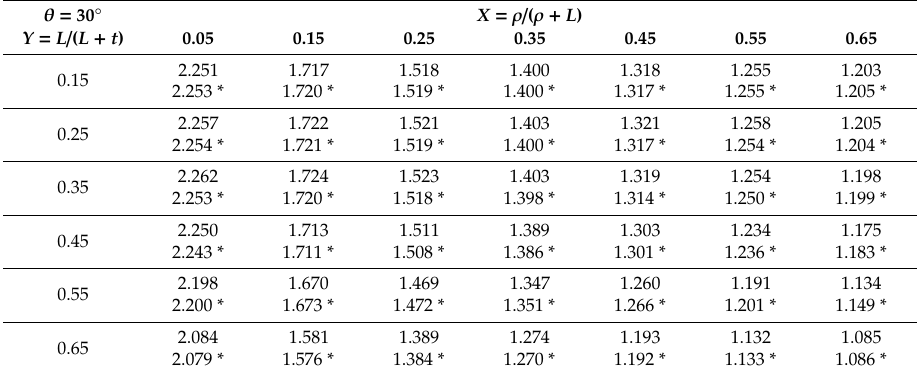
Table 3. Comparison of SCF s calculated using formula (A1) (*) to the FEM results for a Double-V butt-welded joint subjected to tensile loading, where θ = 30 ◦ .